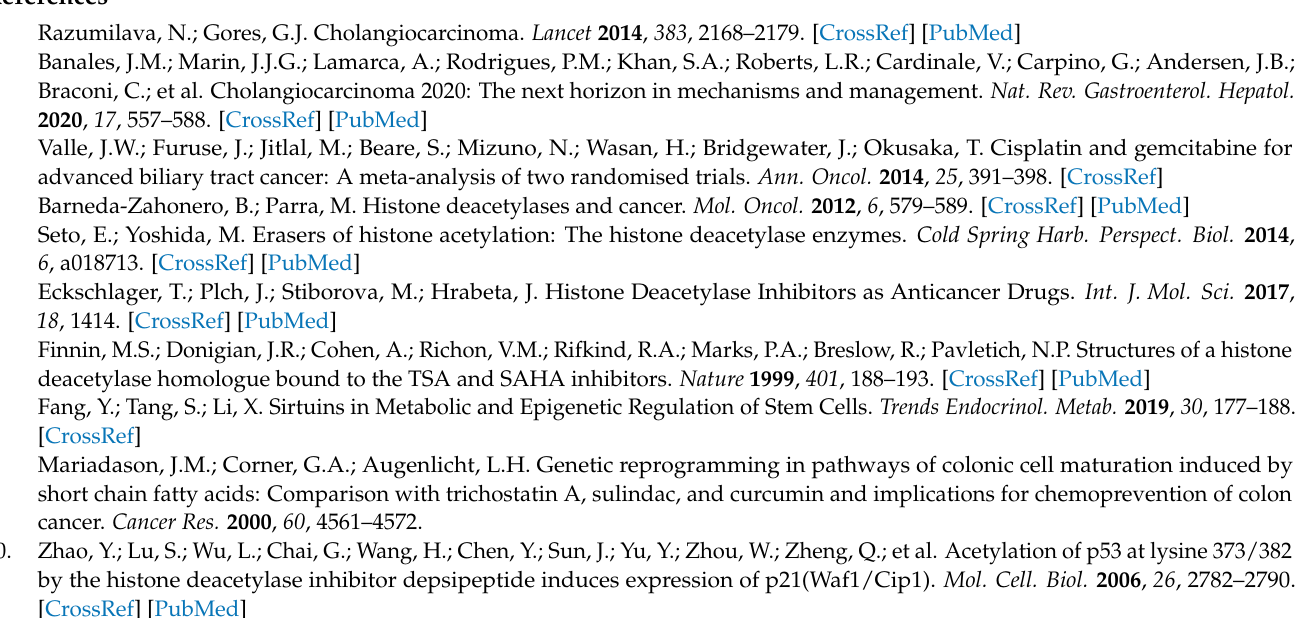
Figure S5. Reduction of cell viability of BTC cells by romidepsin using the SRB assay, Figure S6. Statistics for Figure 4A,B, Figure S7. Evaluation of combined romidepsin and cisplatin treatment, Figure S8. ROC analysis. For HDAC 1 (A) and HDAC 2 (B), Figure S9. In silico analysis for HDAC 1 and HDAC 2 expression/survival data using, Figure S10. Calculation of logistic regression-derived p -values for HDAC 1 (A) and HDAC 2 (B), Figure S11. Original blots for Figure 3, Figure S12. Original blots for Figure